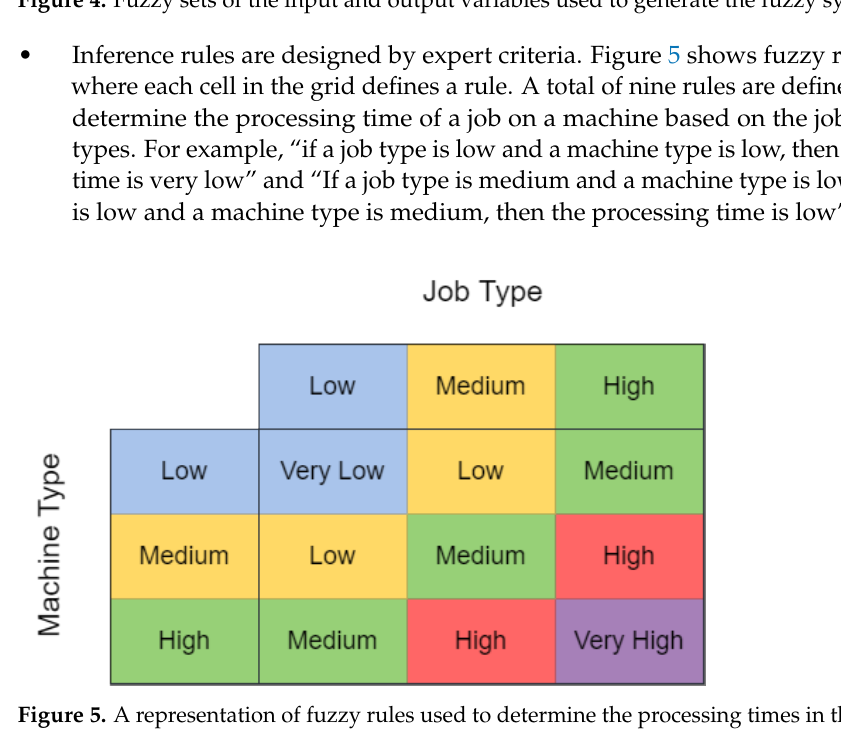
Figure 4. Fuzzy sets of the input and output variables used to generate the fuzzy system.